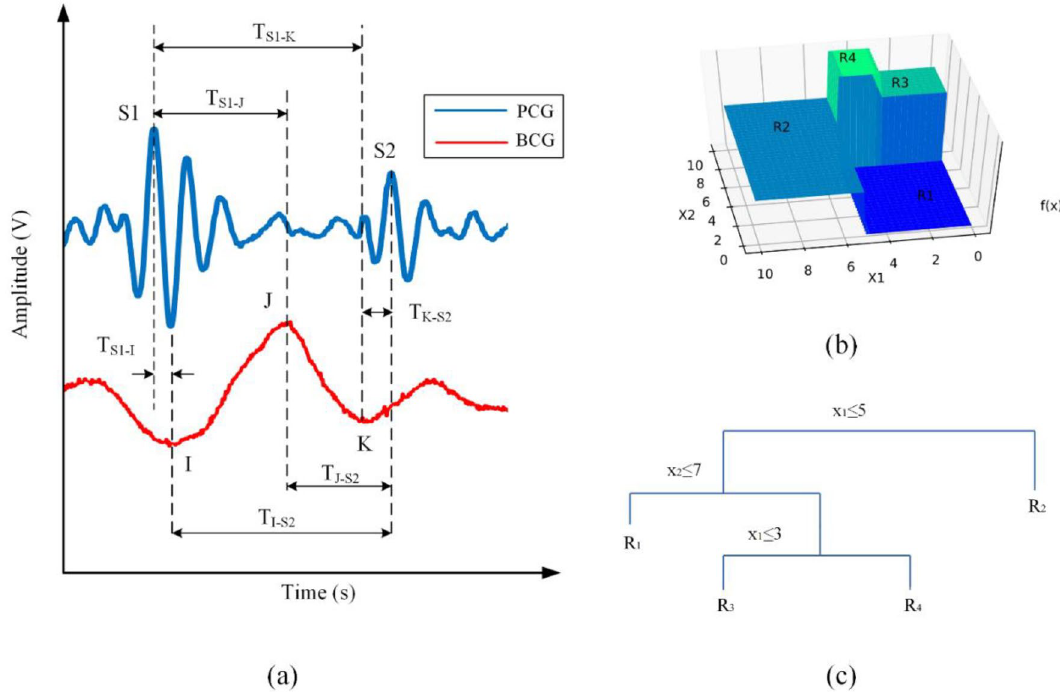
Figure 1. ( a ) Time intervals between the PCG and the BCG. ( b ) Example of a tree model, where the tree input 2 space is a box of R and a partition of the input space, and ( c ) the associated decision